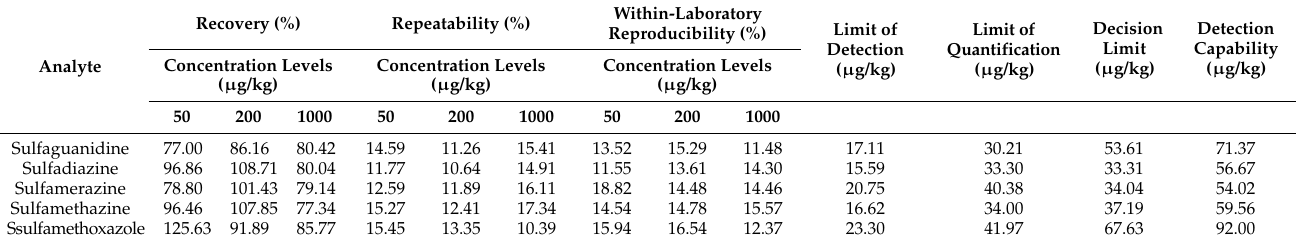
Table 2. Validation results for pig and poultry feces.